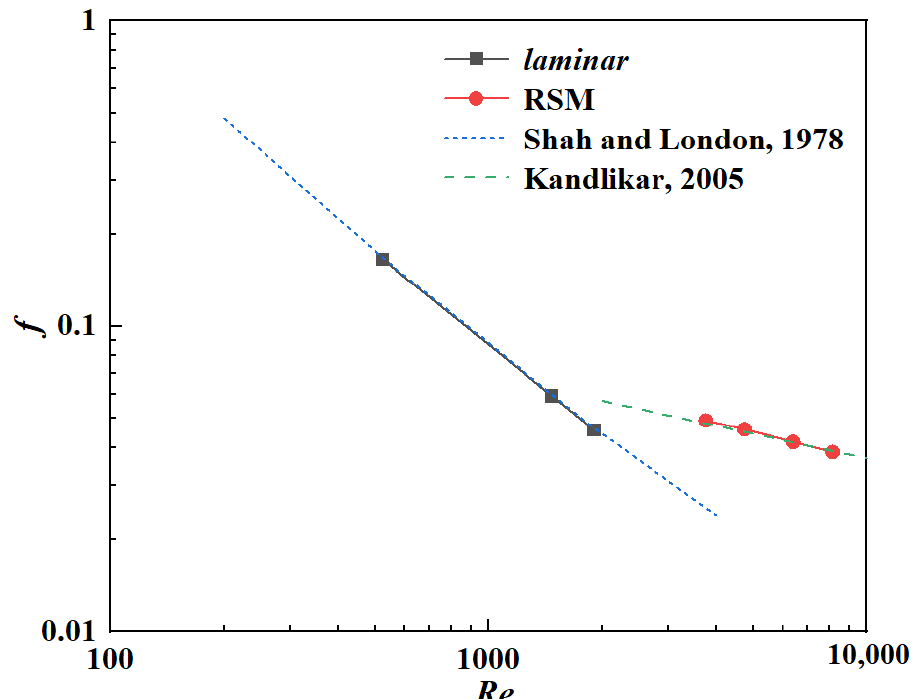
Figure 5. Turbulence model validation.